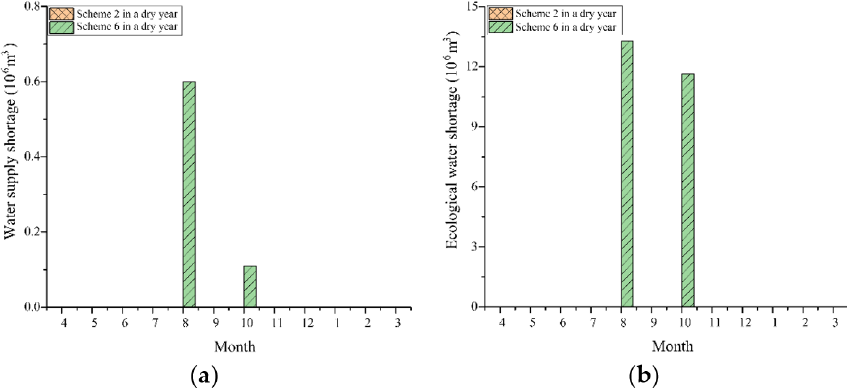
Figure 13. Water shortage downstream during flood season in a dry year: ( a ) Water supply shortage; and ( b ) Ecological water